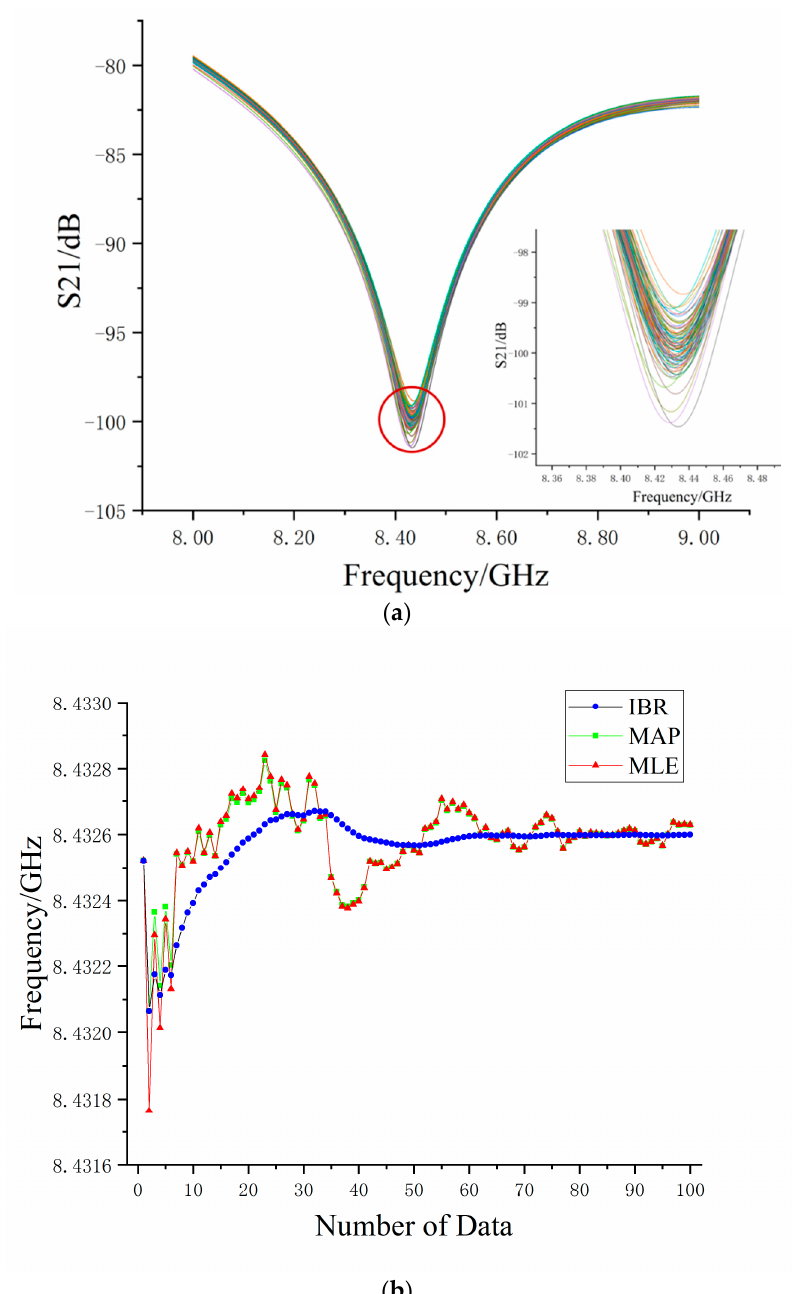
Figure 7. ( a ) 100 measured data of interference fringes for the S-parameter at 720 με strain. ( b ) Estimated frequency at the valley of measured data.